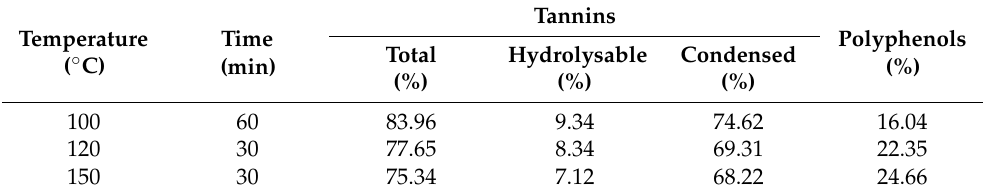
Table 10. Distribution of HTs, CTs, and polyphenols in optimized SI-SWE of CW chips.